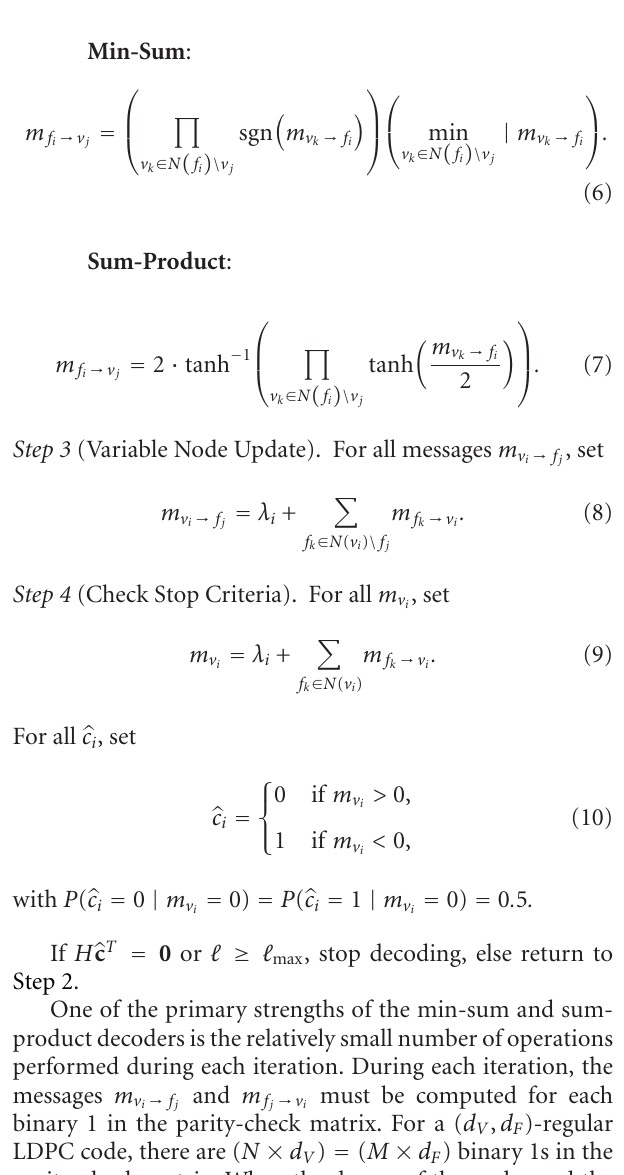
Algorithm 1 (Min-Sum/Sum-Product